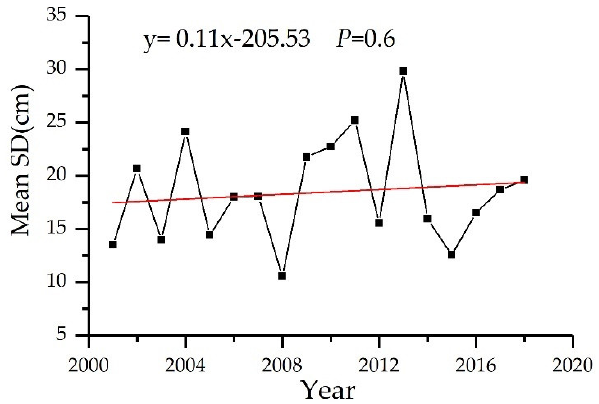
Figure 4. Interannual variation in mean of snow depth during the period of 2001–2018.